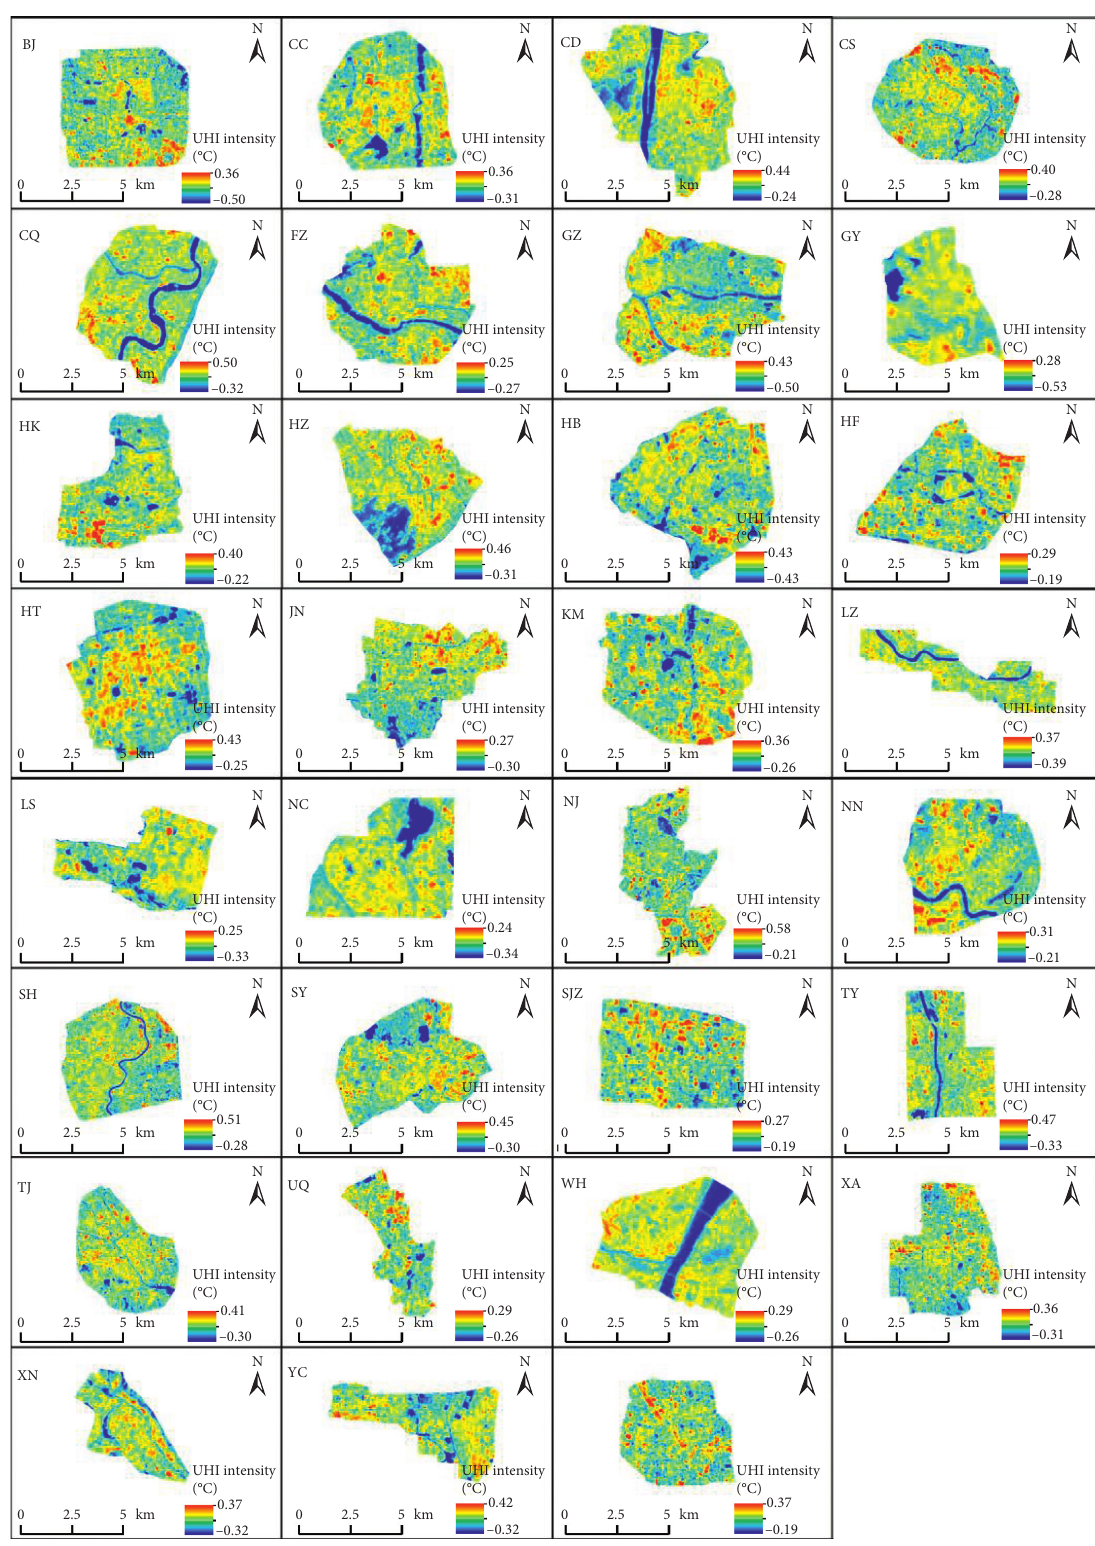
Figure 3: The spatial distribution of the relative UHI intensity in provincial cities of mainland